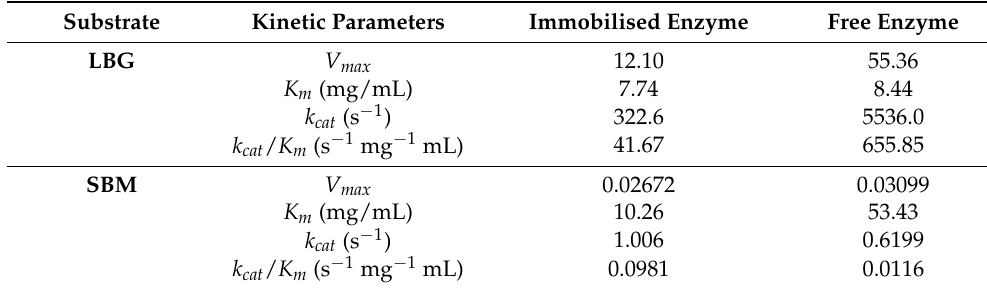
Table 1. Kinetic parameters of free and immobilised endo-1,4- β -mannanase with LBG (0.05–0.15% ( w / v )) and SBM (3.0–8.0% ( w / v )).